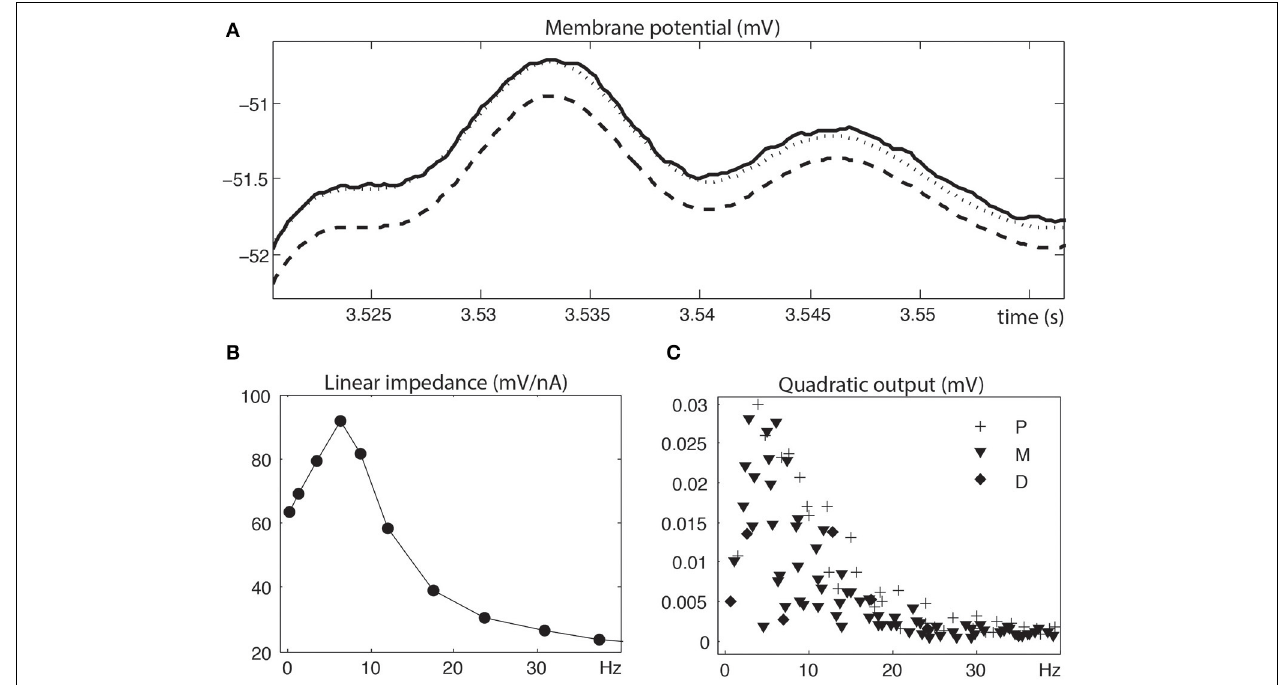
FIGURE 2 | Linear and quadratic analyses of a depolarized stellate neuron. (A) Zoomed measured membrane potential (solid), linear reconstruction (dashed) and linear + quadratic reconstruction (dotted). (B) Linear impedance at input frequencies (circle symbol at f i ). (C) Quadratic output at harmonics (diamond symbol at 2 f i ), interactive sums (plus symbol